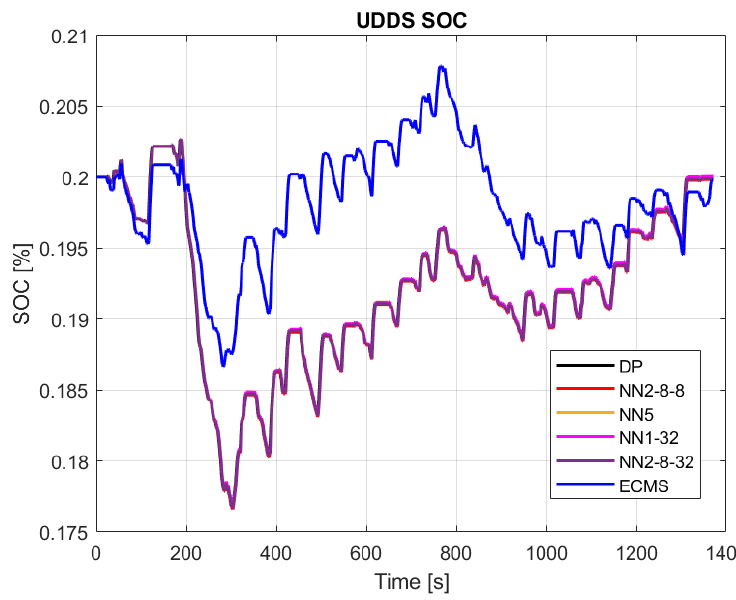
Figure 9. SOC results for UDDS drive cycle. Table 4. UDDS results